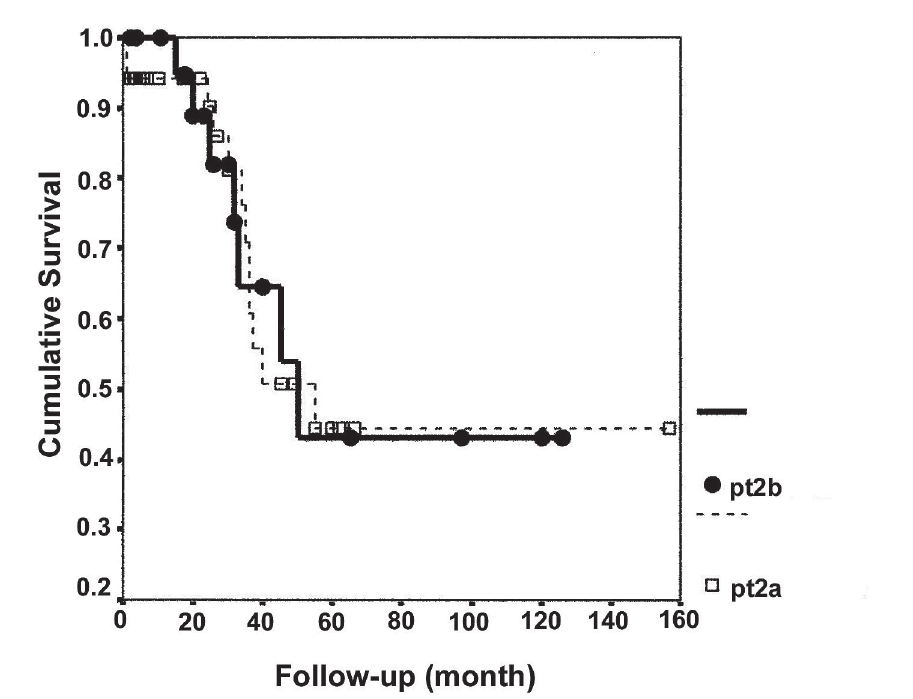
Figure 1 – Kaplan-Meier curve demonstrating cumulative survival in patients with pT2a and pT2b bladder cancer.